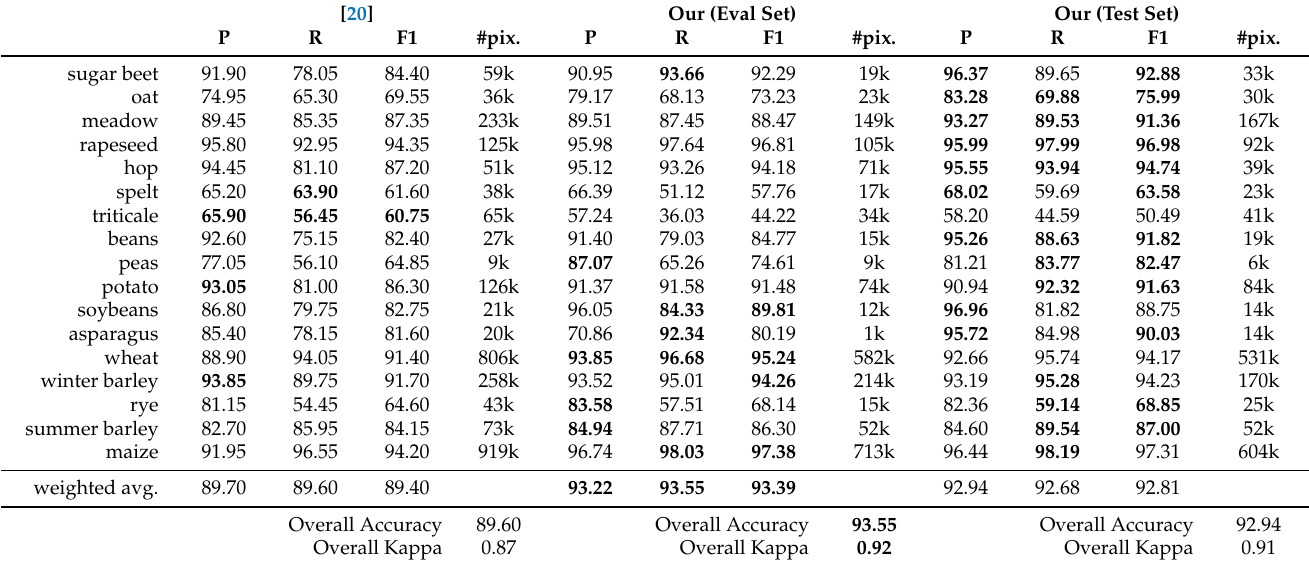
Table 1. Numerical results of the comparison made with what was published in paper of Rußwurm and Korner. Our model uses a Resnet101, trained for 300 epochs on the training set. We report the comparison measures on the test set and on the validation set (we did not do hyperparameter tuning). In this experiment no techniques or weights were used to solve the problem of unbalanced classes. All measurements, except the Kappa, are in